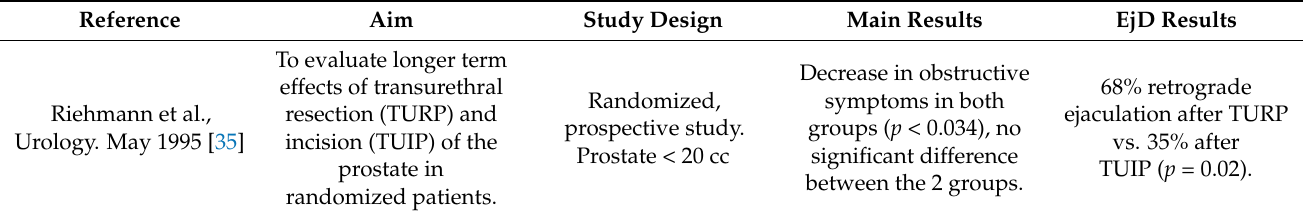
Table 4. Impact of trans-ureteral resection of prostate and trans-ureteral incision of prostate on the ejaculatory status.